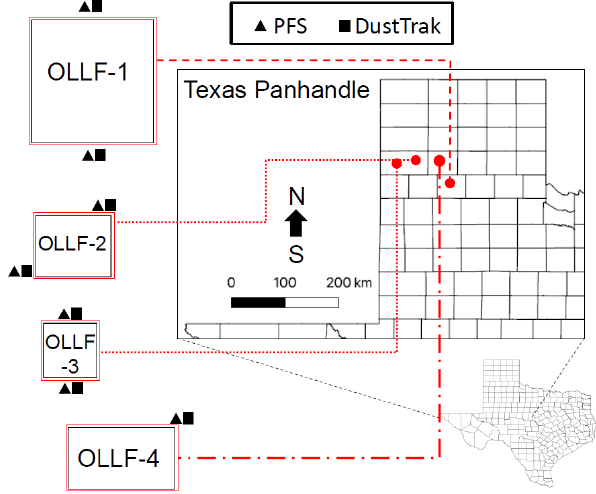
Figure 2. Schematic of the field sampling activity at individual sites (only the counties are shown). The dimension of each facil- ity (east–west × north–south) is (1) 1.6 × 1.6km, (2) 1.0 × 0.8km, (3) 0.7 × 0.7km, and (4) 1.4 × 0.8km. A combination of polycar- bonate filter samplers (PFSs) and DustTrak instruments was used at the nominally upwind and downwind edges of OLLF-1 to